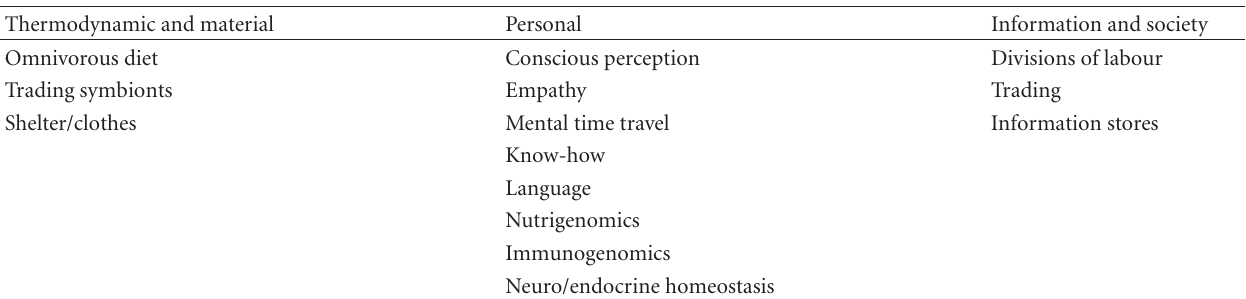
Table 1: Three worlds that interact are largely human thermodynamic and cognitive niche constructions that are all heritable making us codirectors of our own and our collaborators evolution. There is a cost to this cumulative evolution that may include hypo- and hypervitaminosis, energy, and informatic